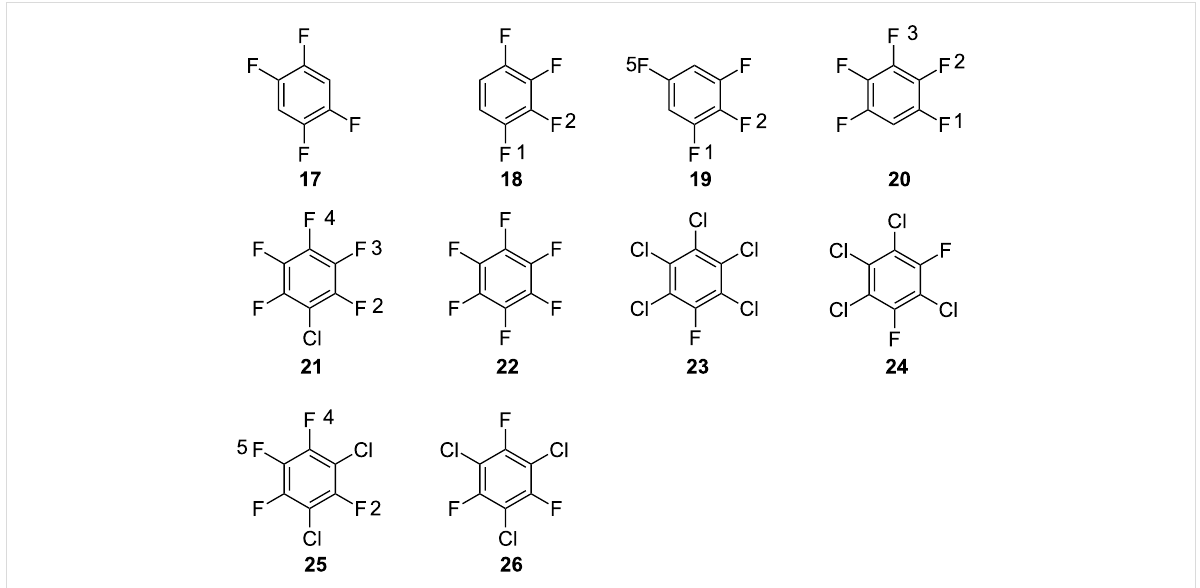
Figure 3: The structures investigated in the methoxylation of polychlorofluorobenzene derivatives (series C) and the numbering of their positions.